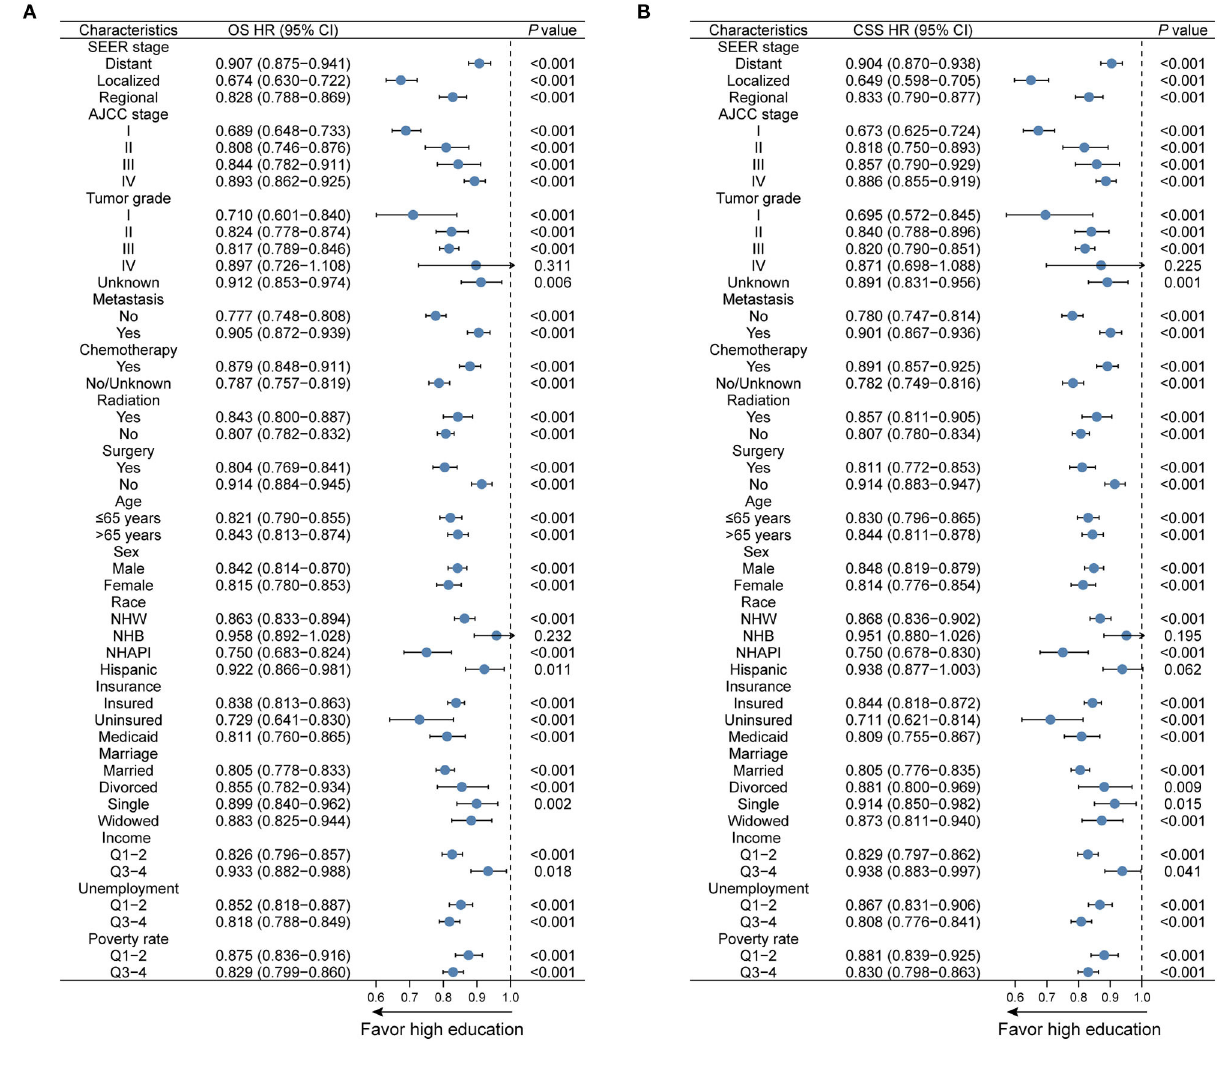
FIGURE 4 | Subgroup analyses regarding education level for (A) OS and (B) CSS in the overall cohort. OS, overall survival; CSS, cancer-specific survival; HR, hazard ratio; CI, confidence interval; NHW, non-Hispanic White; NHB, non-Hispanic Black; NHAPI, non-Hispanic Asian or Pacific